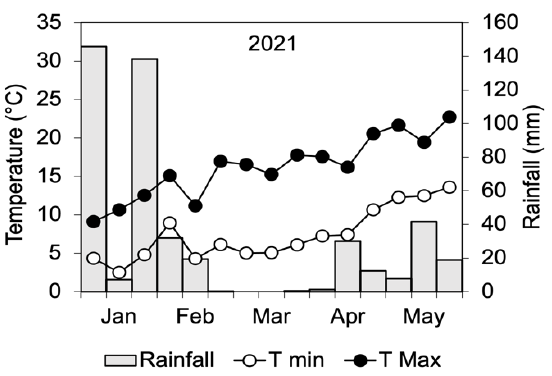
Figure 3. Decadic mean and maximum temperatures and cumulated rainfall during the period of wood distillate distribution to the field bean crop.